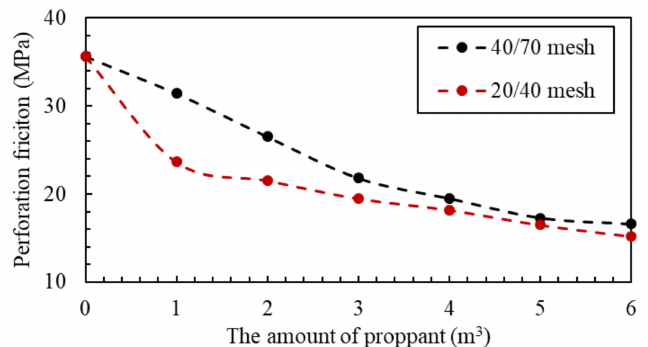
Figure 10. Perforation friction vs. proppant dosage at different proppant